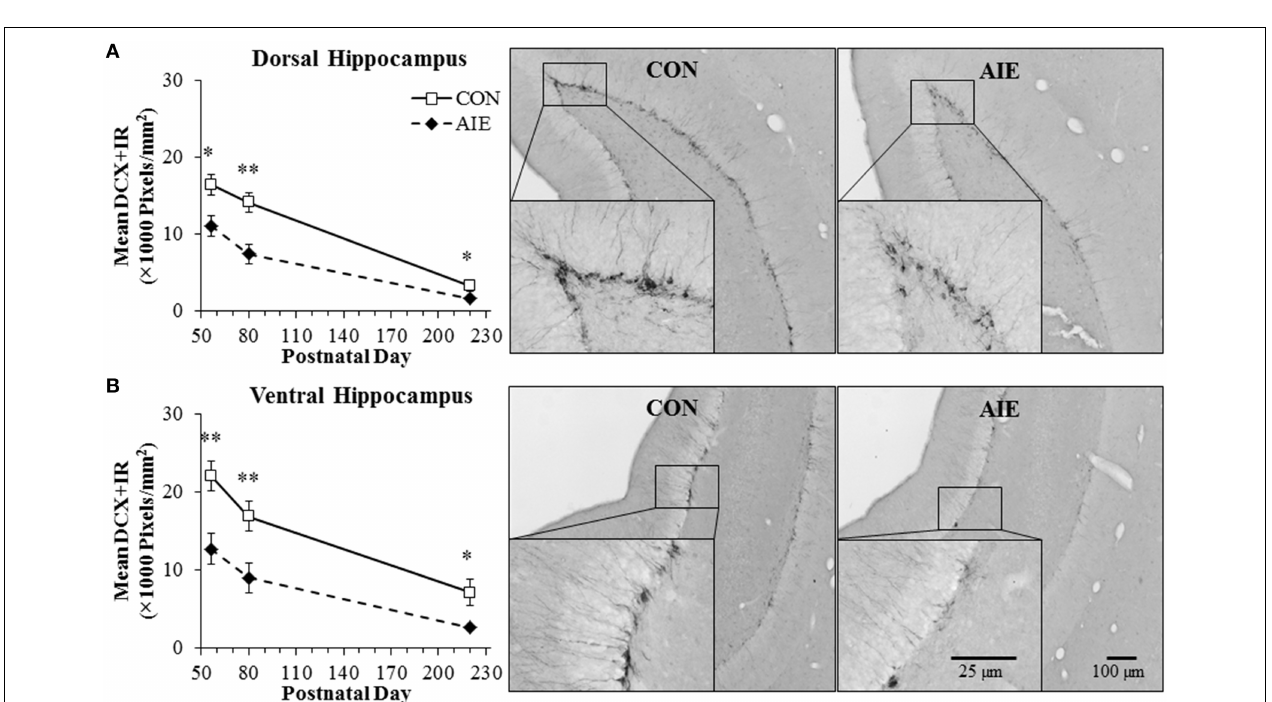
FIGURE 2 | Adolescent intermittent ethanol (AIE) exposure leads to long-term reductions of doublecortin-immunopositive (DCX + IR) cells in the dorsal and ventral hippocampal dentate gyrus. (A) Quantification of pixel density revealed a 33% ( ± 4%) decrease of DCX + IR in the adolescent (postnatal [P]56) dorsal hippocampal dentate gyrus that persisted from young adulthood (P80 [48 ± 7%]) into adulthood (P220 [51 ± 6%]), relative to controls (CONs). Included are representative photomicrographs of DCX + IR cells in the dentate gyrus of the dorsal hippocampus from young adult (P80)